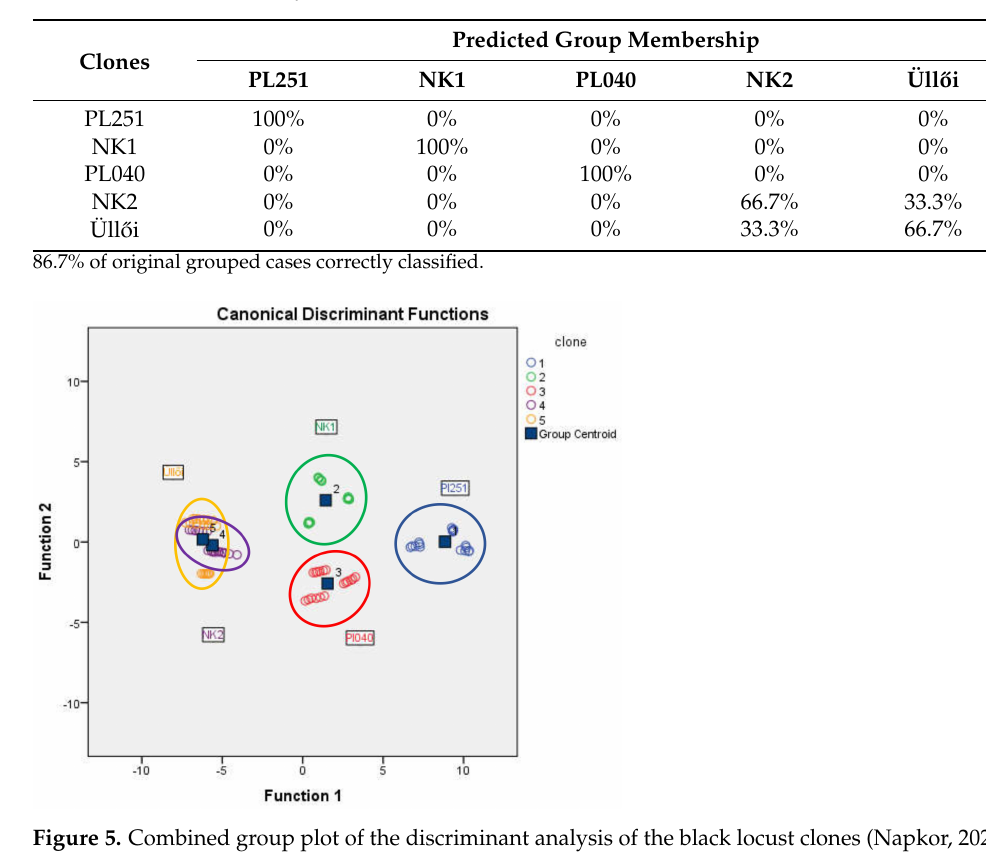
Table 2. Discriminant analysis classification results, black locust clones.